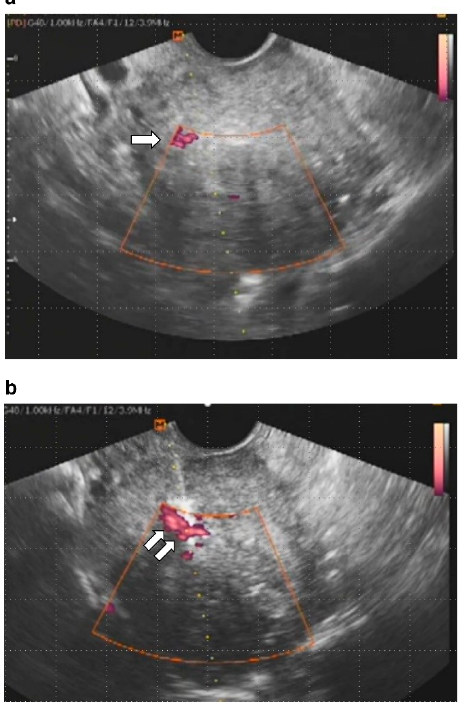
Figure 4. Intraoperative transvaginal ultrasound: ( a ) After locating the inflowing vessels of the myoma under transvaginal ultrasound using a color Doppler method ( ⇒) ; ( b ) microwave ablation of the inflowing feeding vessels of uterine fibroids using a needle-shaped deep coagulation electrode under transvaginal ultrasound guidance can be confirmed as a hyperechoic area. ( ⇒⇒) . Subjective assessment using the visual analog scale showed a considerable improve- ment in clinical symptoms.